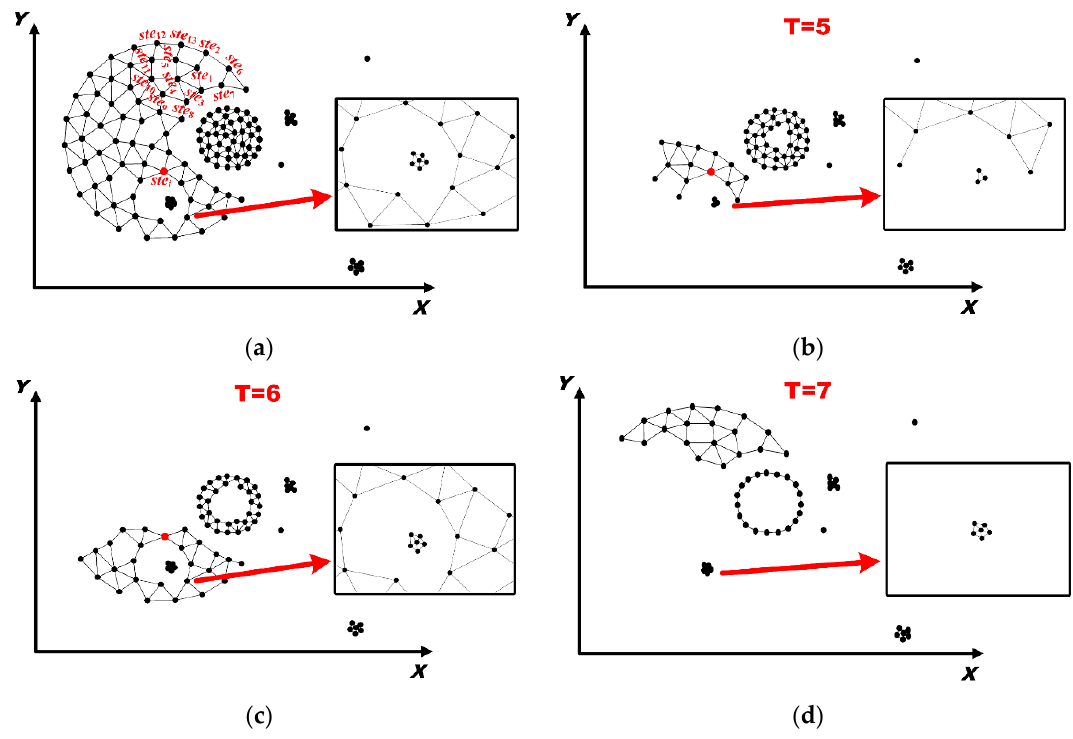
Figure 6. The construction of spatial proximity relationships. ( a ) spatial Twitter events covering the whole time period; ( b – d ) spatial Twitter events at T = 5, T = 6 and T = 7,